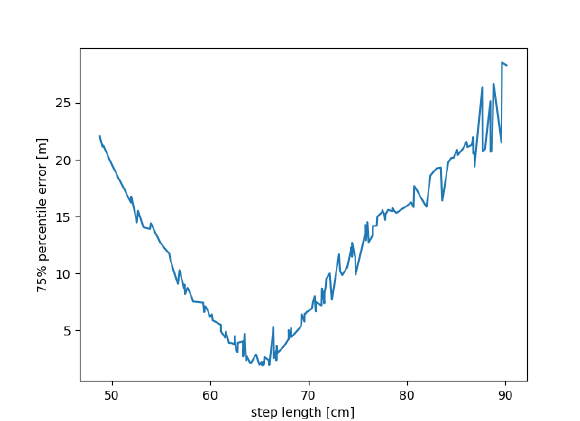
Figure 11. Step lengths are computed as means from all distances between two consecutive steps along the same path. It is not trivial to find the proper configuration for mean step